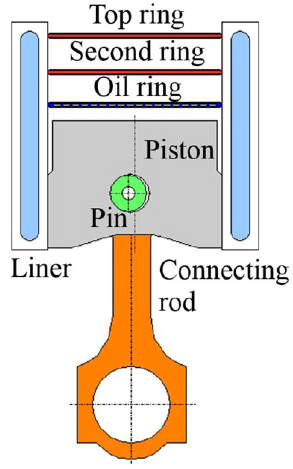
Figure 7. Piston assembly dynamic model.